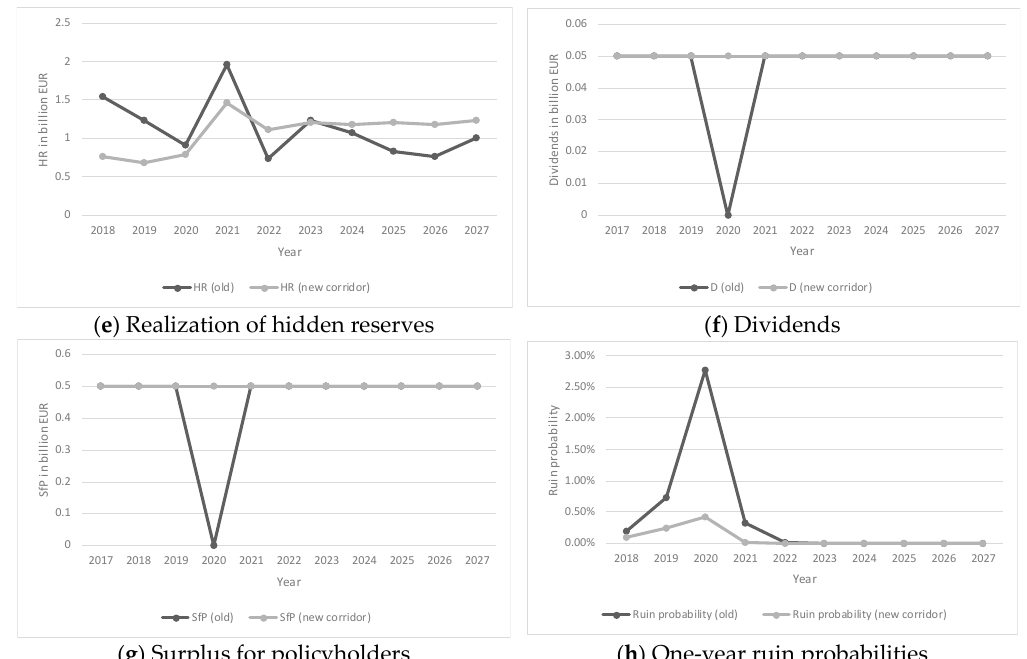
Figure 4. Simulation results in interest rate scenario 4.